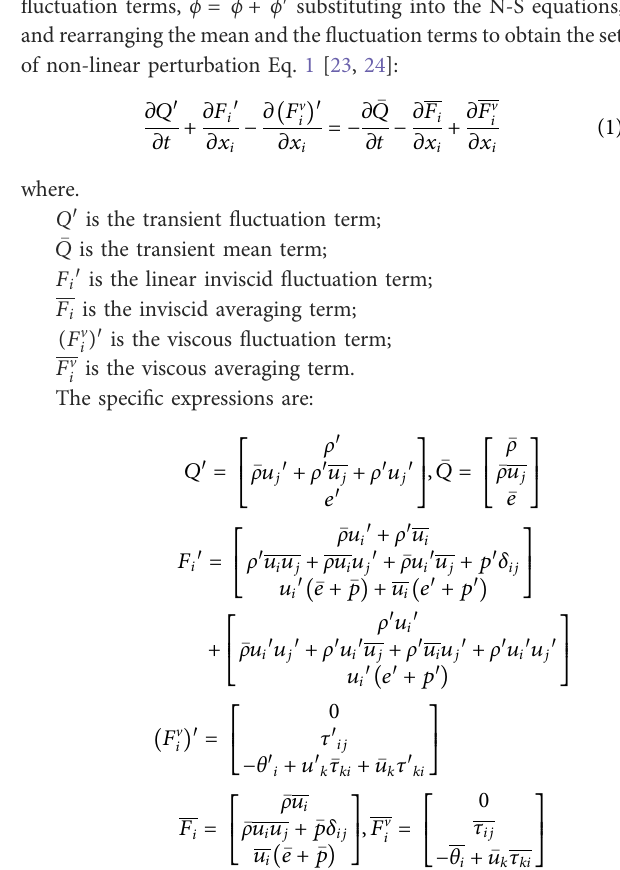
FIGURE 1 Aircraft landing